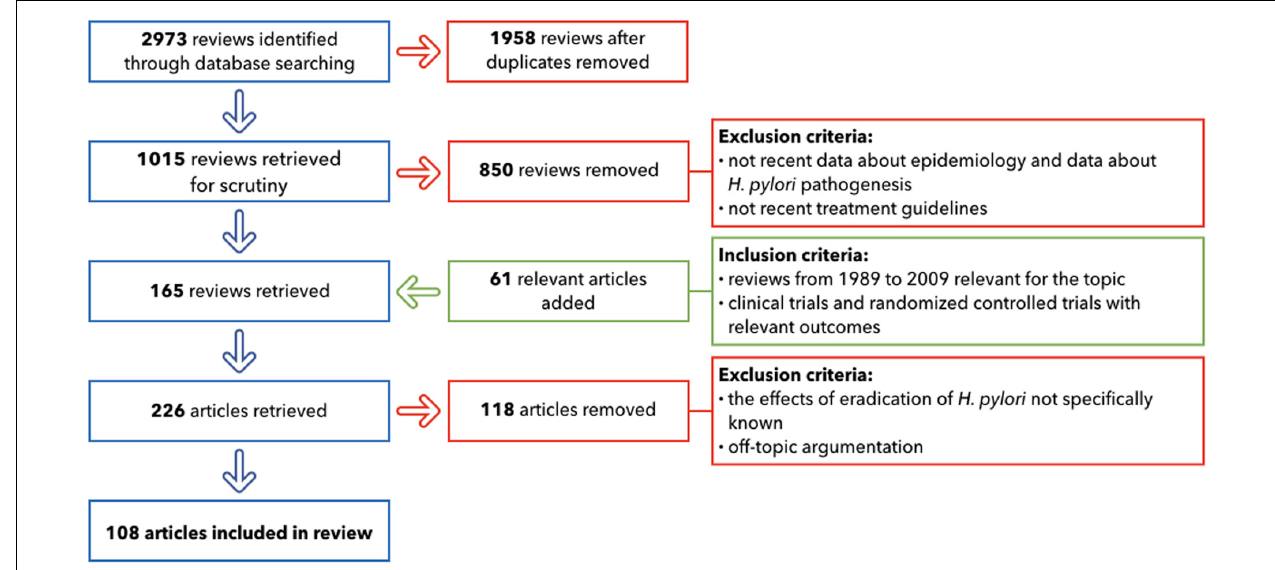
FIGURE 3 | Flow chart of literature selection.